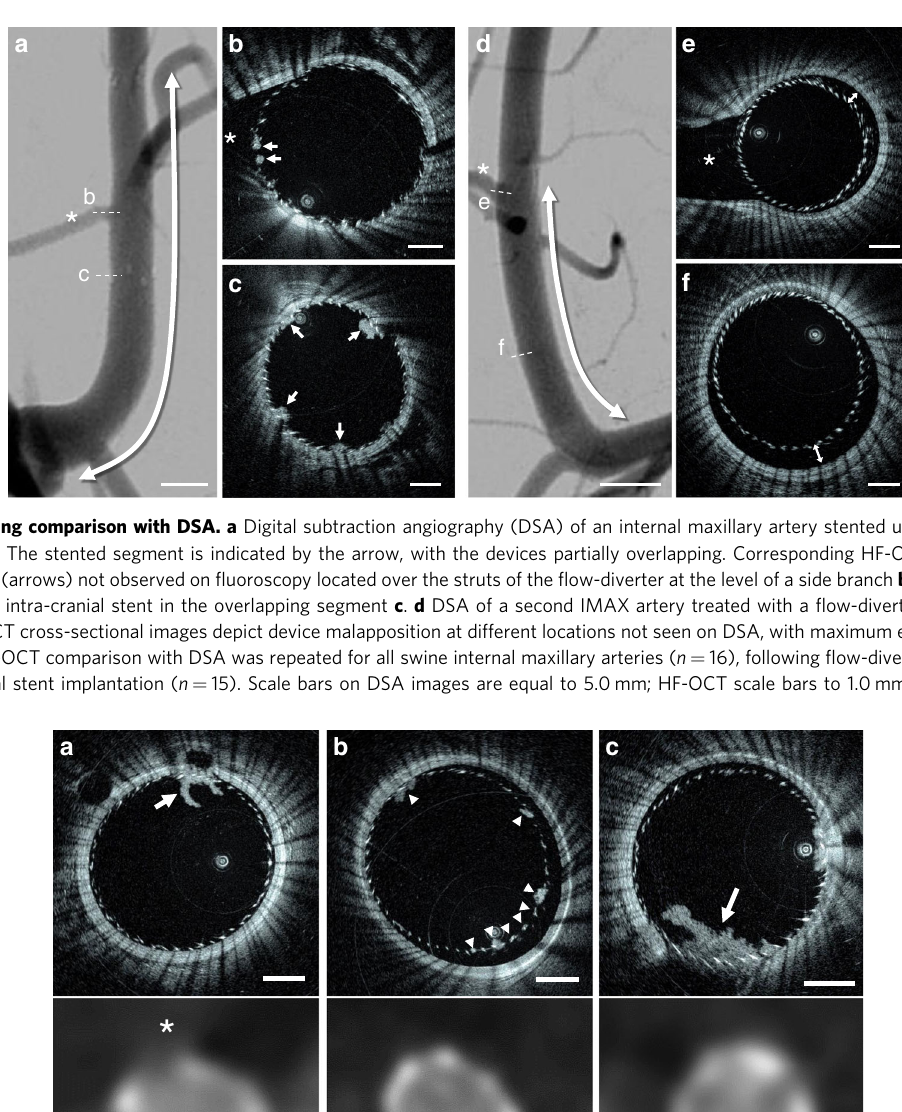
it appears on an image as smearing in the circumferential (rotational) direction, and it causes distortions that may lead to incorrect interpretation and measurements 15 . In the elevated tortuosity of brachial arteries ( n = 16), HF-OCT data sets had no observed NURD artifacts (Fig. 2). Distortion-free imaging with uniform vessel wall illumination allowed precise visualization of the individual tissue layers including the internal and external elastic laminae, detailed lumen anatomy, and the ostia of two side-branches (Fig. 2b, c).